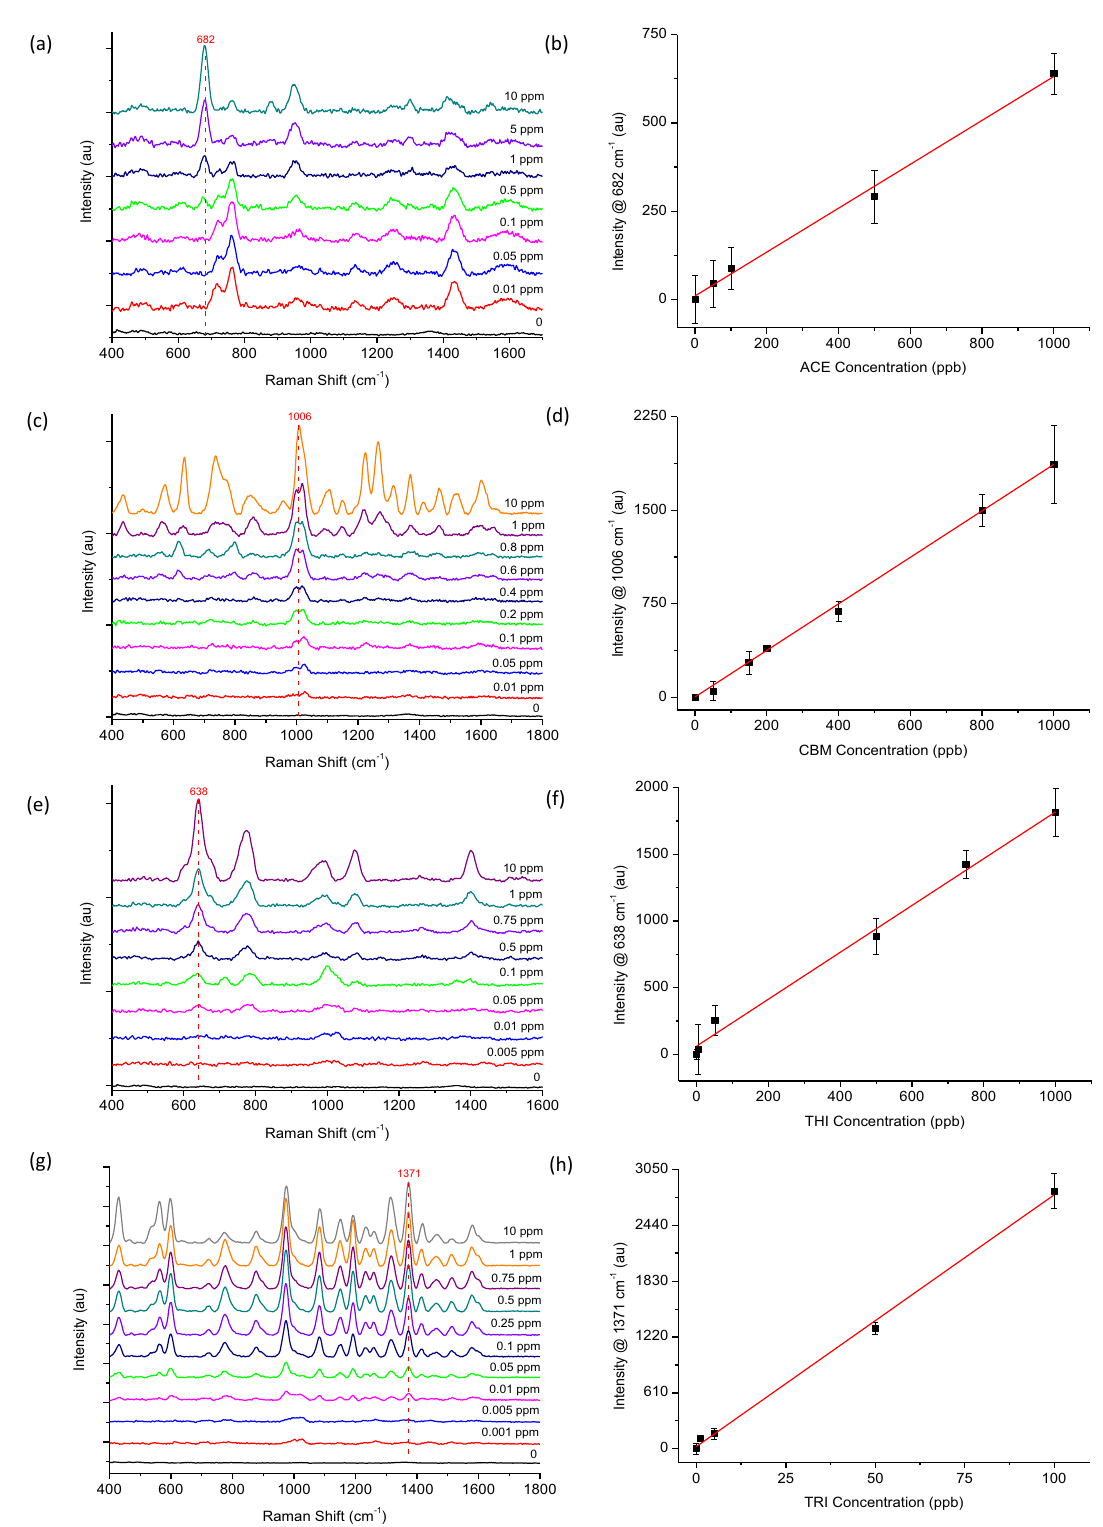
Fig. 4 Analysis of pesticide standard solutions (in solvent) using handheld-SERS. a , c , e , g Spectrum of ACE, CBM, THI and TRI with increasing concentrations, respectively. b , d , f , h Linear relationship between increasing SERS intensity and the concentration of ACE, CBM, THI and TRI, respectively. All data was normalised relative to the blank (zero) and the standard deviation ( σ ) was calculated from triplicate samples ( n =